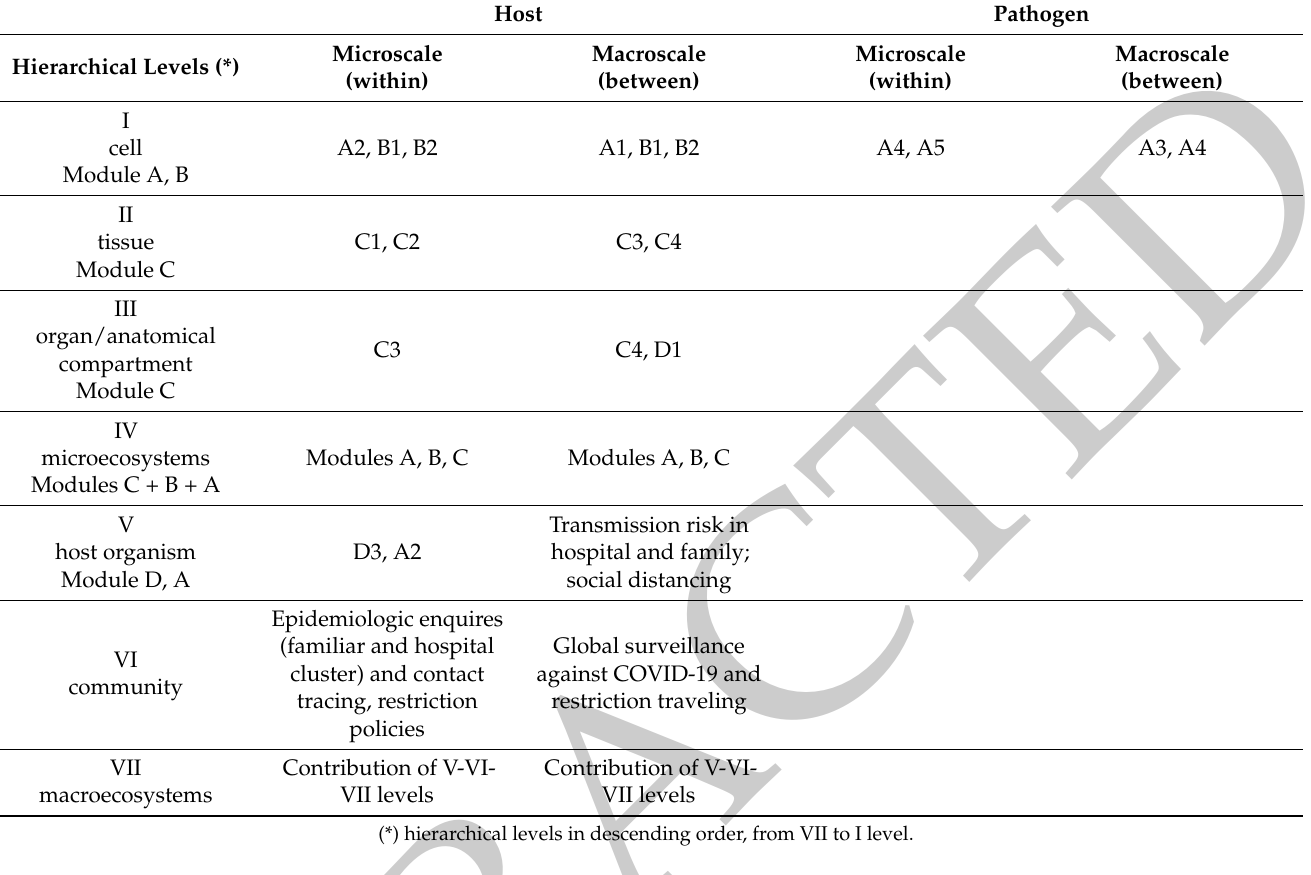
Table 3. Alignment between biological modules and hierarchical levels. Submodules were posed in macroscale/microscale.